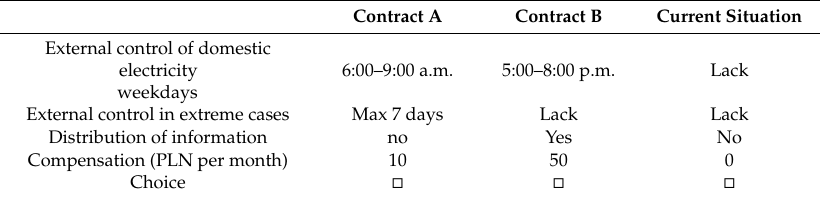
Table 2. Example of choice